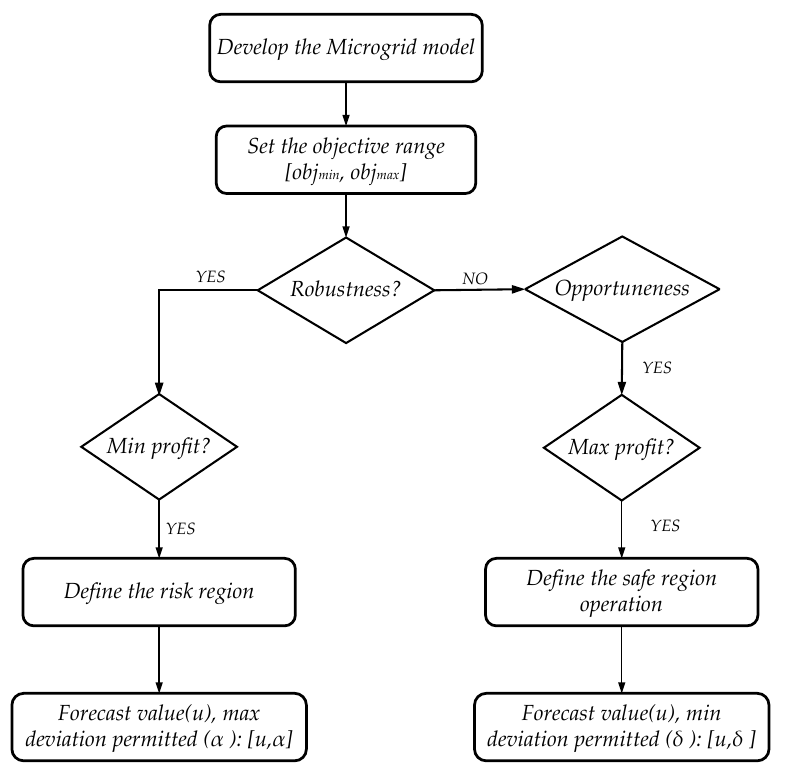
Figure 9. Information gap decision theory flow chart [91].